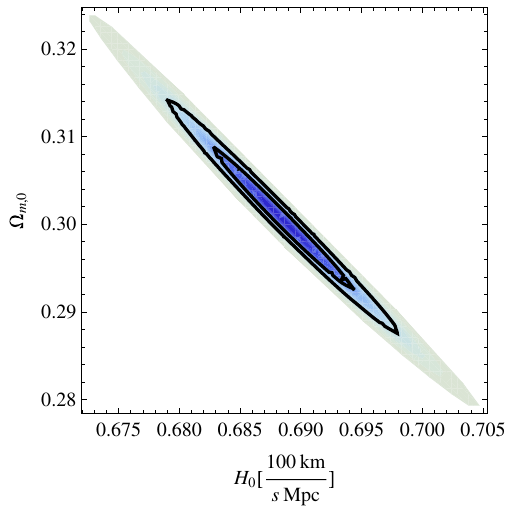
Fig. 12 The intersection of the likelihood function of two model parameters ( (cid:5) m , 0 , H 0 ), with the marked 68 and 95% confidence levels. The plane of the intersection is α = 0 . 5 and E 0 = 10 120